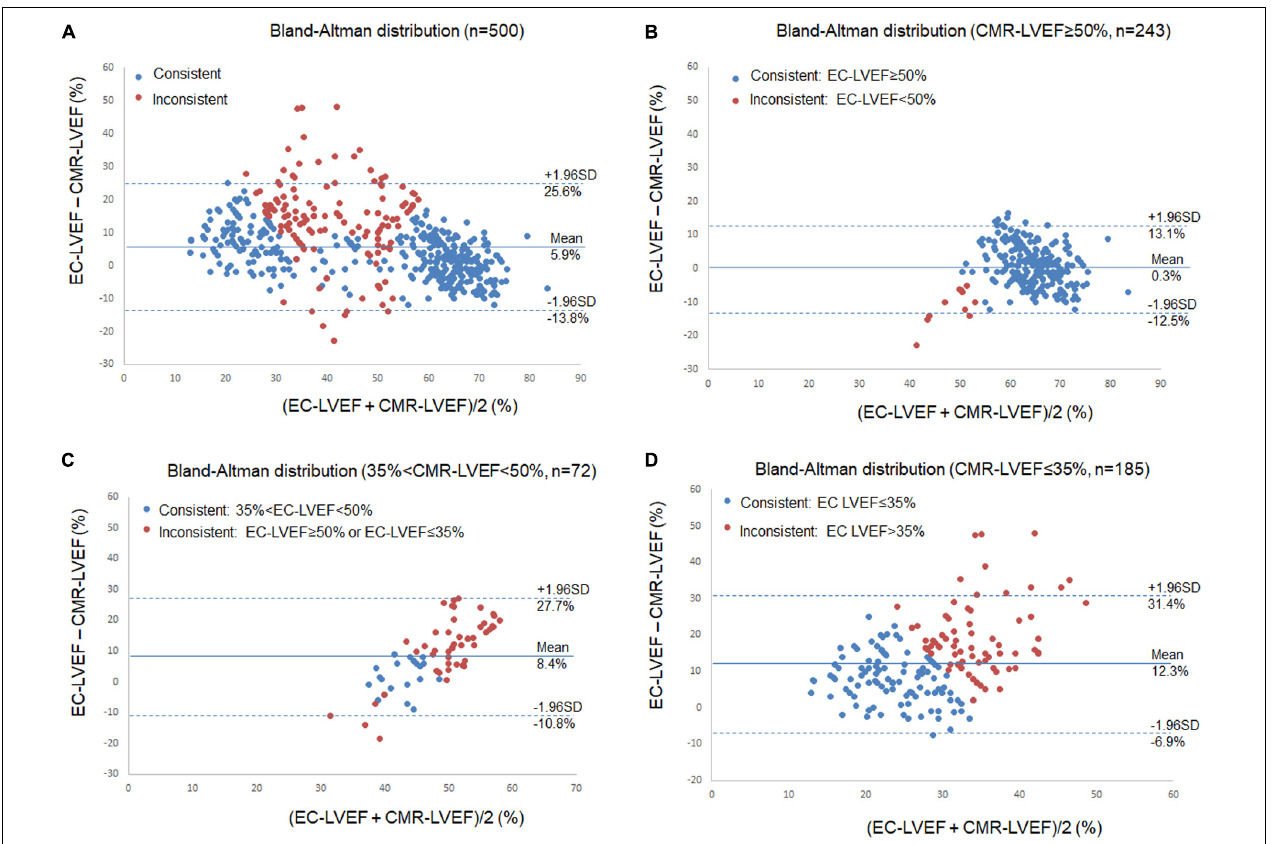
FIGURE 1 | Bland-Altman Plot for Left Ventricular Ejection Fraction (LVEF). Comparisons of echocardiography (EC) LVEF with cardiac magnetic resonance (CMR) LVEF. Blue dots indicate those patients their LVEF were measured consistently between EC and CMR, and red dots indicated those with inconsistent measures. (A) all patients, 27.8% patients had inconsistent measures (139/500); (B) 243 patients with CMR-LVEF ≥ 50%, 4.5% patients (n = 11) had inconsistent measures; (C) 72 patients with 35% < CMR-LVEF < 50%, 70.8% patients (n = 51) had inconsistent measures; and (D) 185 patients with CMR-LVEF ≤ 35%, 41.6% patients (n = 77) had inconsistent